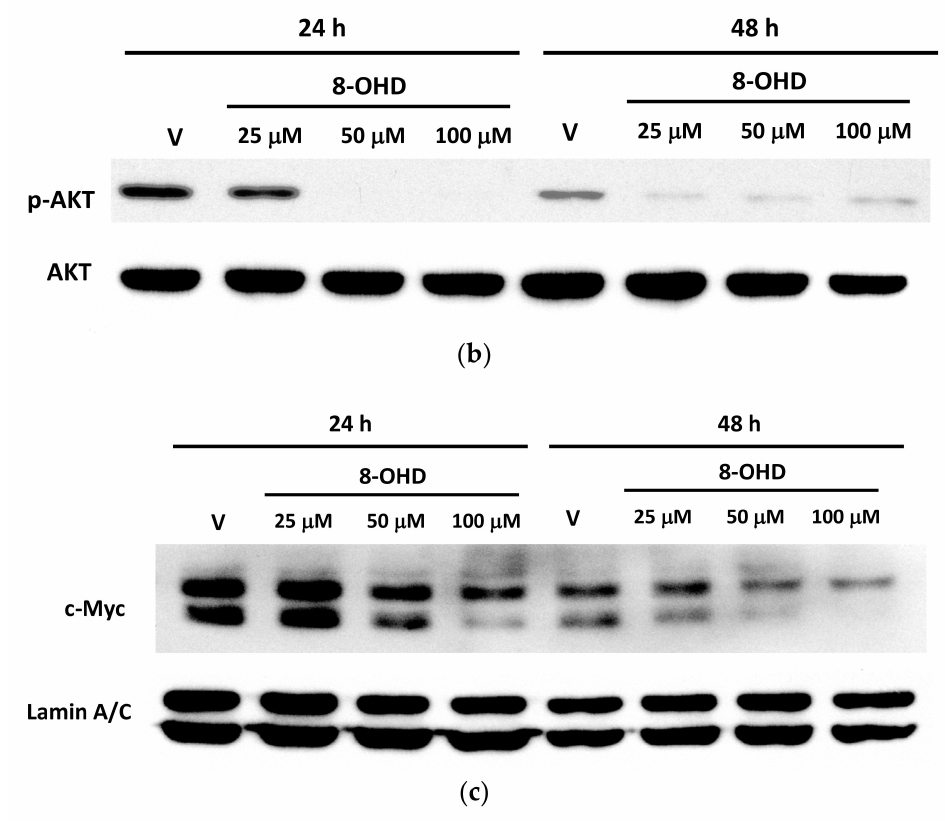
Figure 9. Predicted protein-protein interactions (PPIs) for 8-OHD-downregulated targets associated with myeloid leukemia (ML). ( a ) The PPI network of 112 targets. Corresponding genes were uploaded to query the STRING interaction database. Only the “Experiments”, “Databases”, and “Textmining” source options were selected, and the minimum interaction score was set to 0.4. The line thickness indicates the strength of data support. The solid and the dotted lines respectively indicate connections within the same and different clusters. Those proteins involved in the KEGG acute ML (AML) pathway and chronic ML (CML) pathway are respectively shown in blue and red. ( b ) Dose- and time-dependent inhibitory effects of 8-OHD on the phosphorylation of Akt (Ser473) in K562 cells. ( c ) Effects of 8-OHD on the nuclear c-Myc level. Lamin A/C was used as the loading